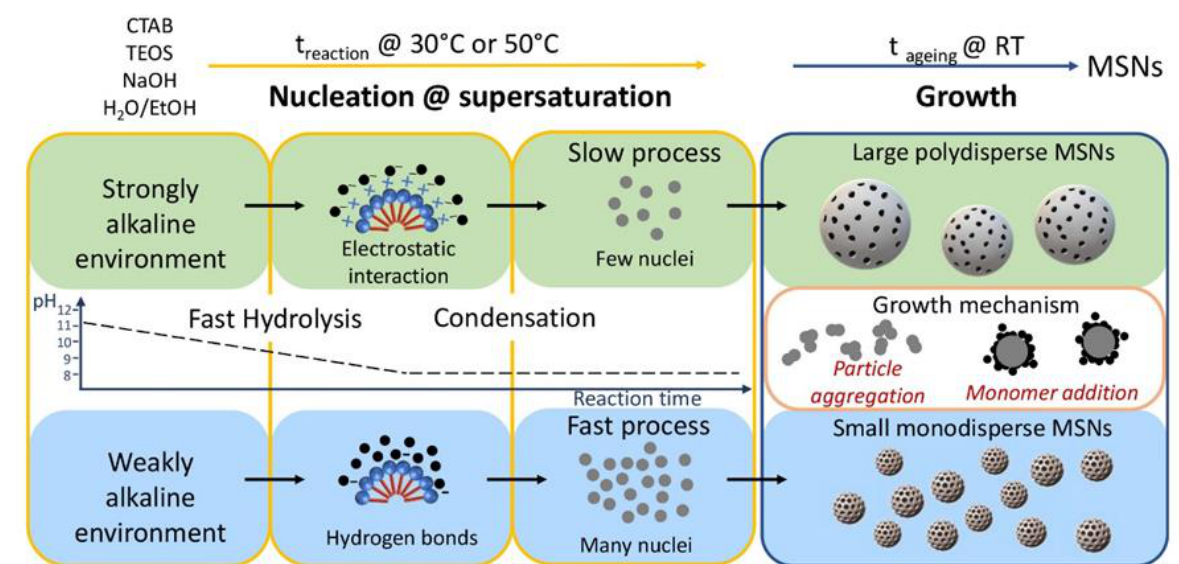
Figure 3. Scheme of the pH-dependent nucleation and growth of the MSNs, prepared in homogenous solution. pH value controls the kinetic of hydrolysis and condensation during the nucleation at high reaction temperature (t reaction ), and the growth step at room temperature.